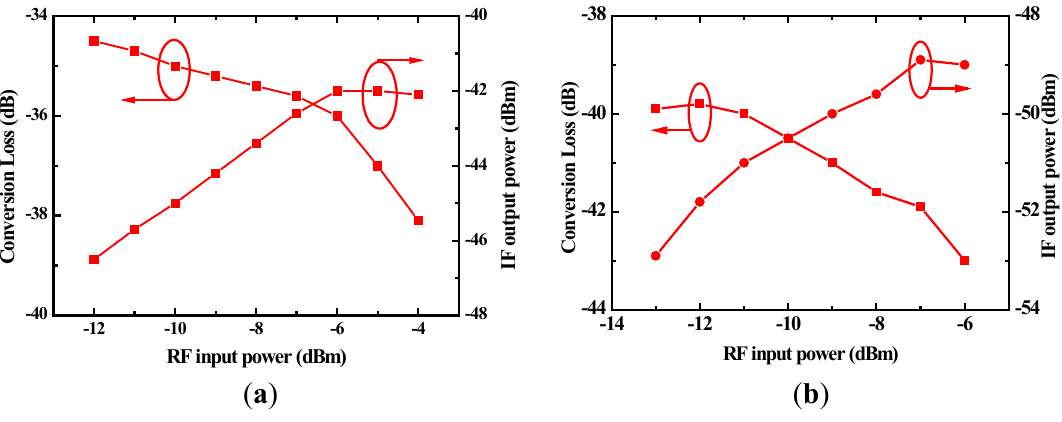
Figure 7. Measured and simulated conversion loss of the SHM: ( a ) 2× SHM and ( b ) 4× SHM.